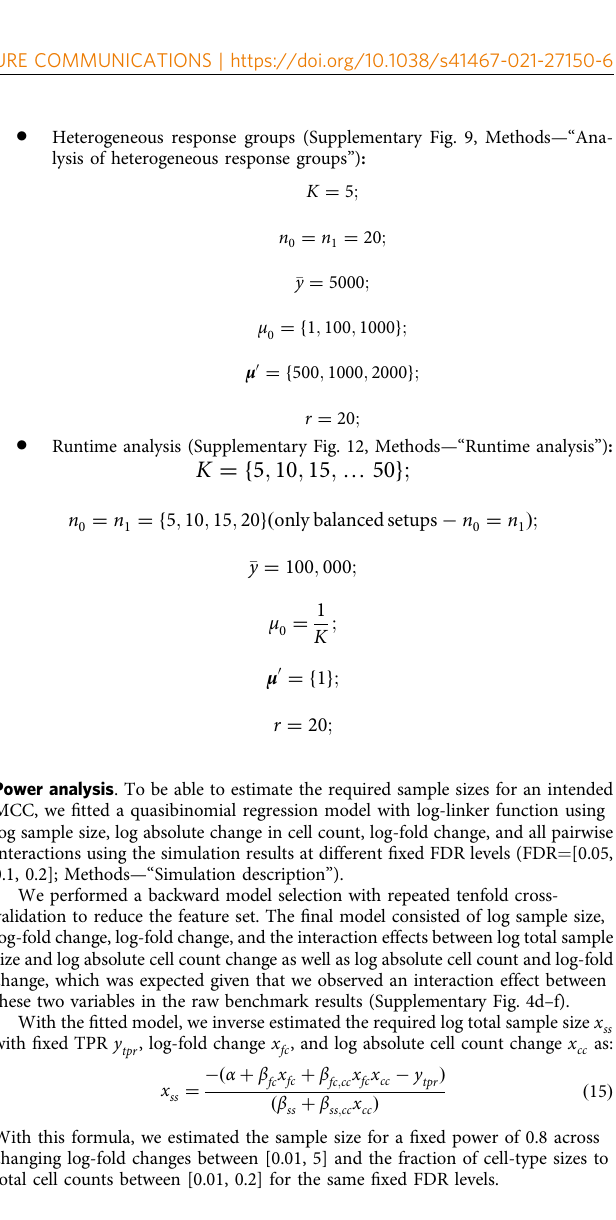
● Model comparison (Fig. 2, Methods —“ Model comparison ” ): K ¼ f 5 ; 10 ; 15 g